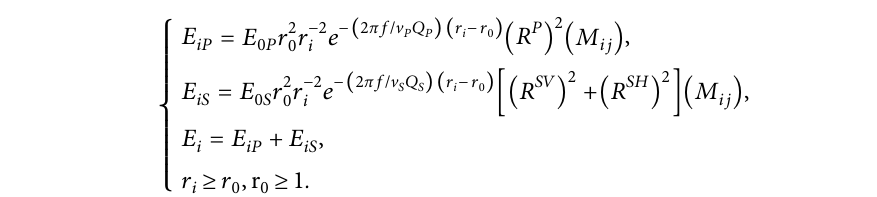
Figure 6. Te faster is the propagation and dissipation rate of